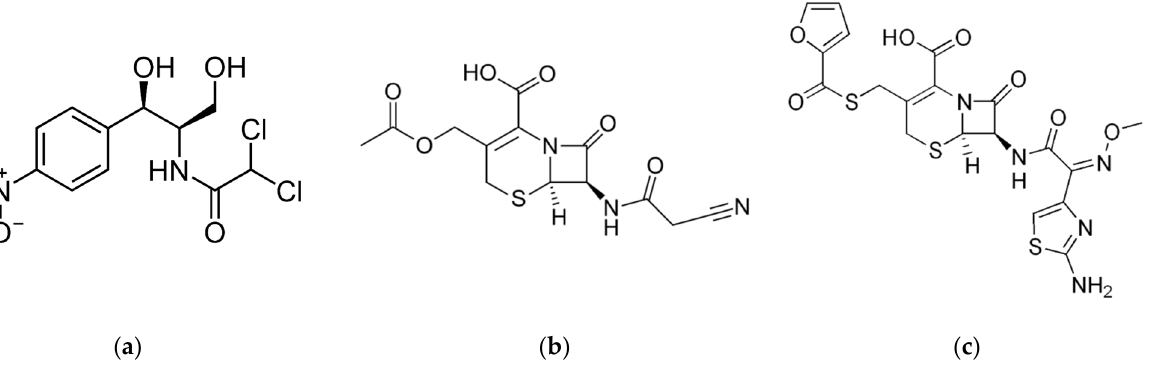
Figure 10. Molecular structure of chloramphenicol ( a ), Cefacetrile ( b ), Ceftiofur ( c ).